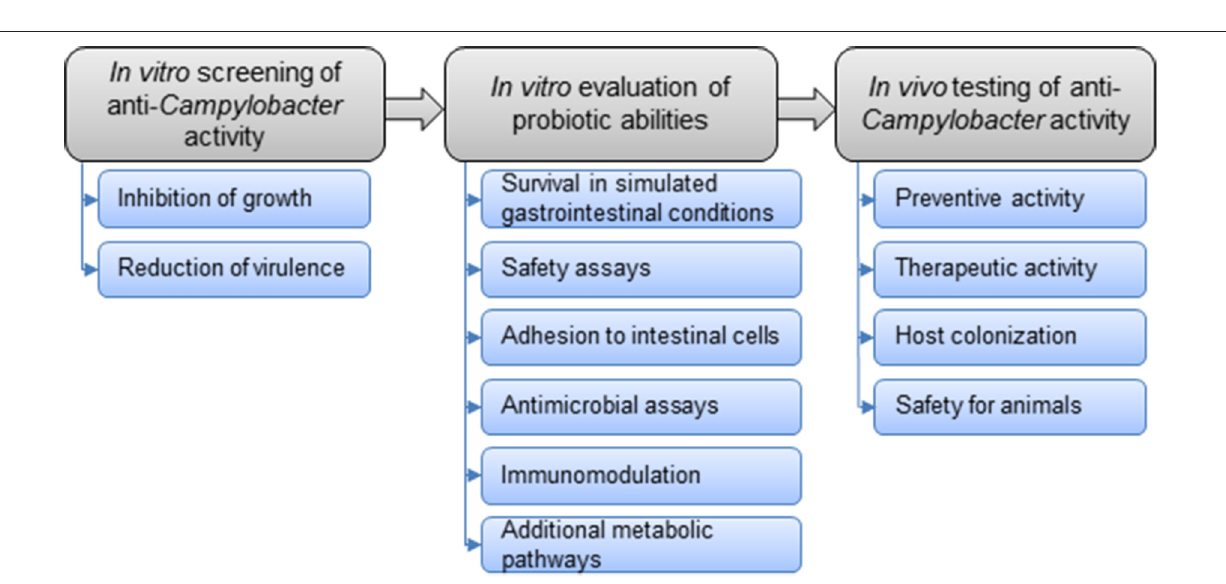
FIGURE 3 | Overall strategy to select potential probiotics to control Campylobacter in